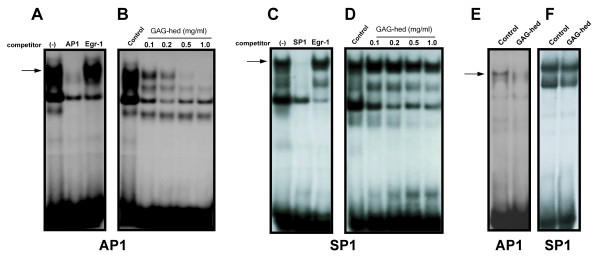
GAG-hed blocks AP1 binding. AP1 DNA binding was performed using electrophoretic mobility shift assays (EMSA) with oligonucleotides containing the HPV18 AP1 binding sequence and the SV40 SP1 bona fide site. Oligomers were end labelled with [α-32P] dATP or [α-32P] dCTP. Nuclear extracts obtained from HeLa cells were exposed to GAG-hed at indicated concentrations for 10 min before labelled probe addition (Panels B and D). On panel A and C, complex specificity is denoted by competition assays with a 100 fold excess of indicated oligonucleotide competitor. In panel E and F, AP1 and SP1 binding respectively, was tested with the same nuclear protein extract obtained from HeLa cells treated in vivo with 5 mg/ml of GAG-hed and harvested 48 h post-treatment. Control indicates untreated cells.